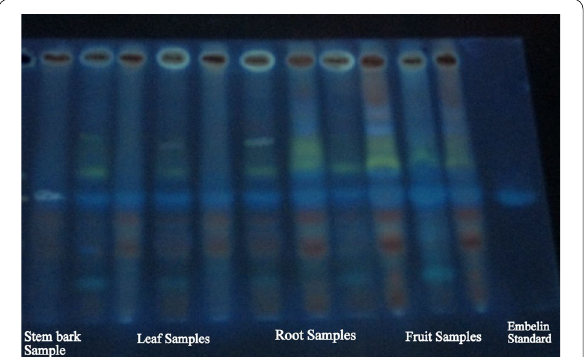
Fig. 1 TLC sheets with sample extracts from different plant parts of A.